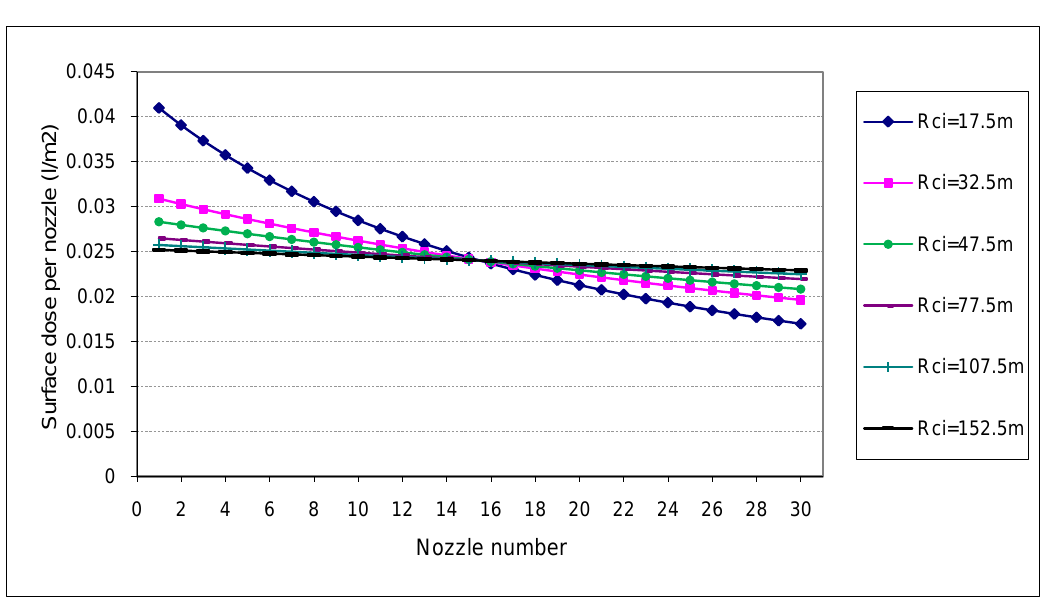
Figure 4. Surface dose (L/m 2 ) applied by each nozzle on a 14.5-m-wide boom with 30 nozzles each separated by 50 cm as a function of the radius of the circular trajectory (Rci). Nozzle 1 = inner nozzle; Nozzle 30 = outer